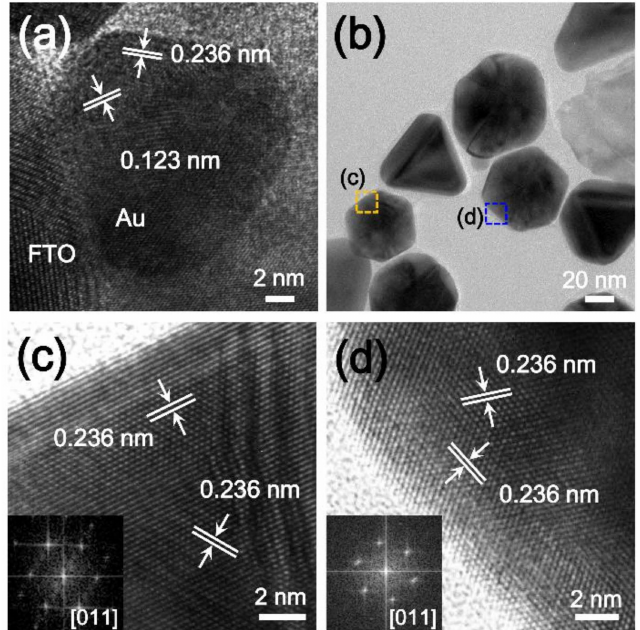
Figure 4. ( a ) Cross-sectional high-resolution transmission electron microscopy (HR-TEM) image of Au NPs on an FTO substrate. The Au NPs directly interfaced with the FTO substrate without any space; ( b ) TEM image of Au NPs detached from the FTO substrate; ( c , d ) HR-TEM images of Au NPs obtained from the ( c ) orange and ( d ) blue boxes of ( b ). Insets are fast Fourier transformation (FFT) patterns of the Au